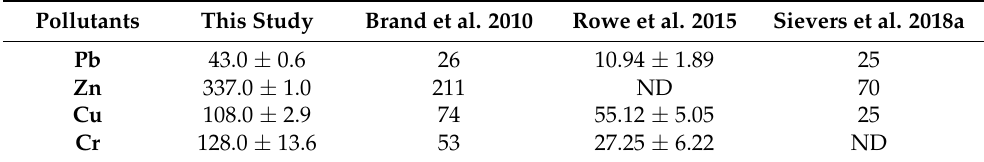
Table 2. Pollutant concentrations in sediment (mg/kg DM) in various studies that investigated effects on